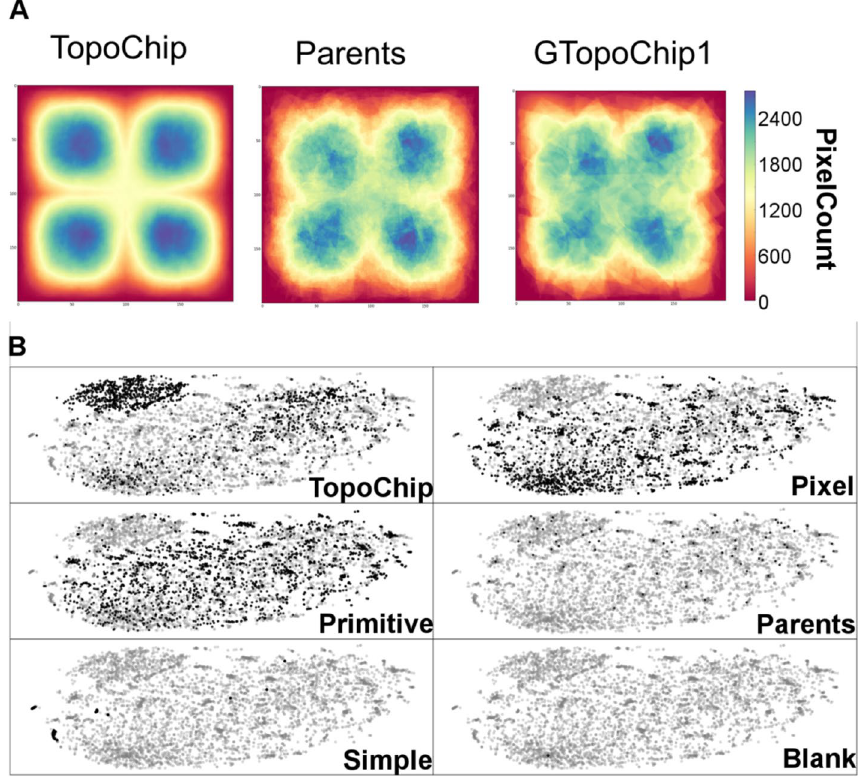
Figure 7. Comparison of GTopoChip1 and original TopoChip. ( A ). Summation of all topographies pixels per group. ( B ) t-SNE visualization of surfaces from TopoChip and